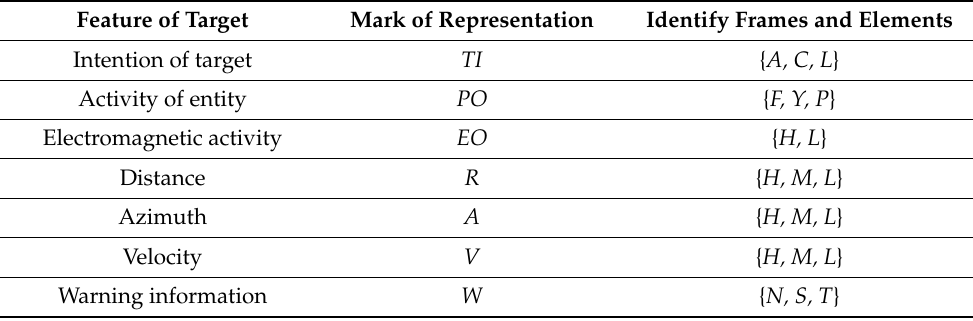
Table 1. Frame description of variables related to target intent